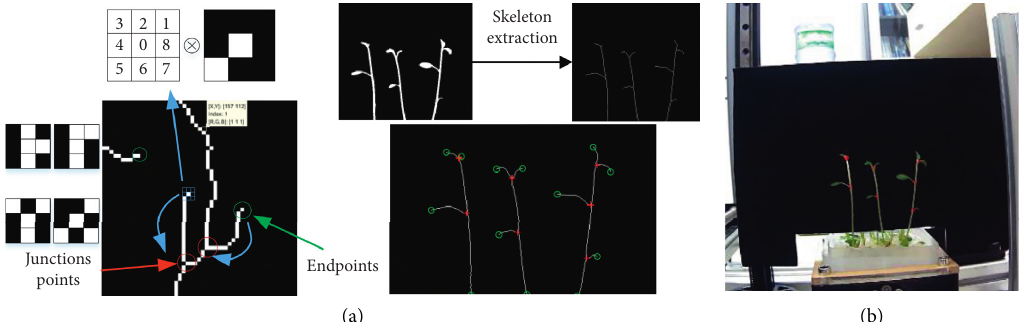
Figure 4: Junction points and endpoint search. (a) Search process. (b) The recognized nodes.